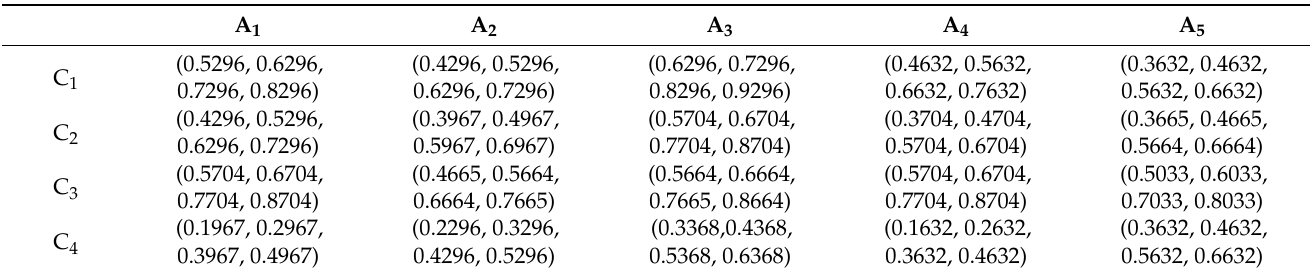
Table 7. Aggregate decision matrix for selecting coal transportation companies.